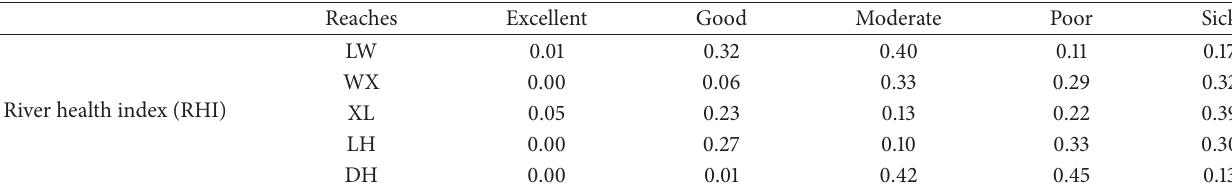
Table 5: Health evaluation results of the Weihe River in Shaanxi